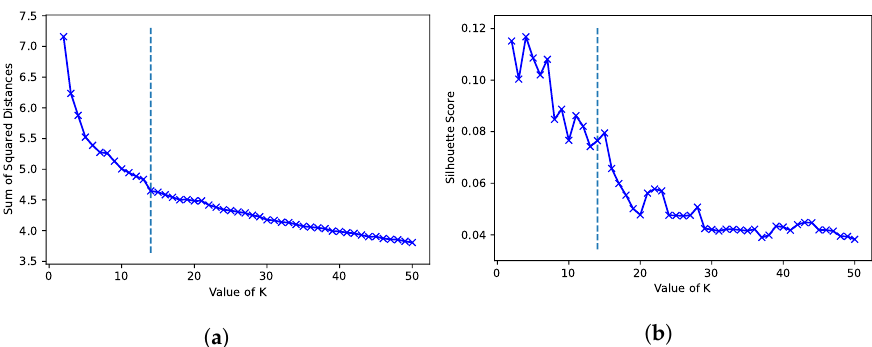
Figure 12. Optimal K for K-means clustering of scaled daily consumption at InfraQuinta, 2017. ( a ) Distortions for each K (Elbow Method). ( b ) Average silhouettes scores for each K.